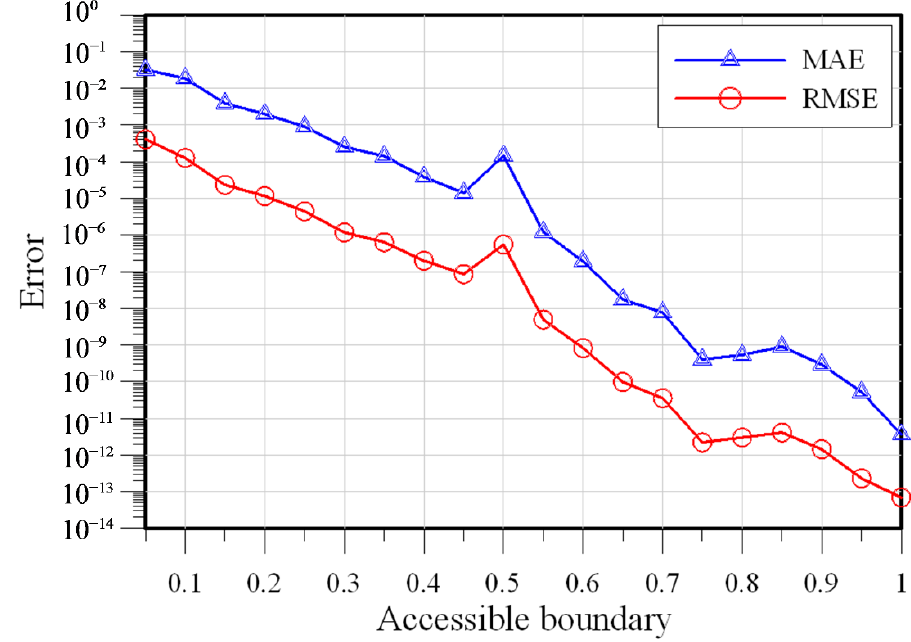
Figure 5. Error versus the proportion of the accessible boundary.